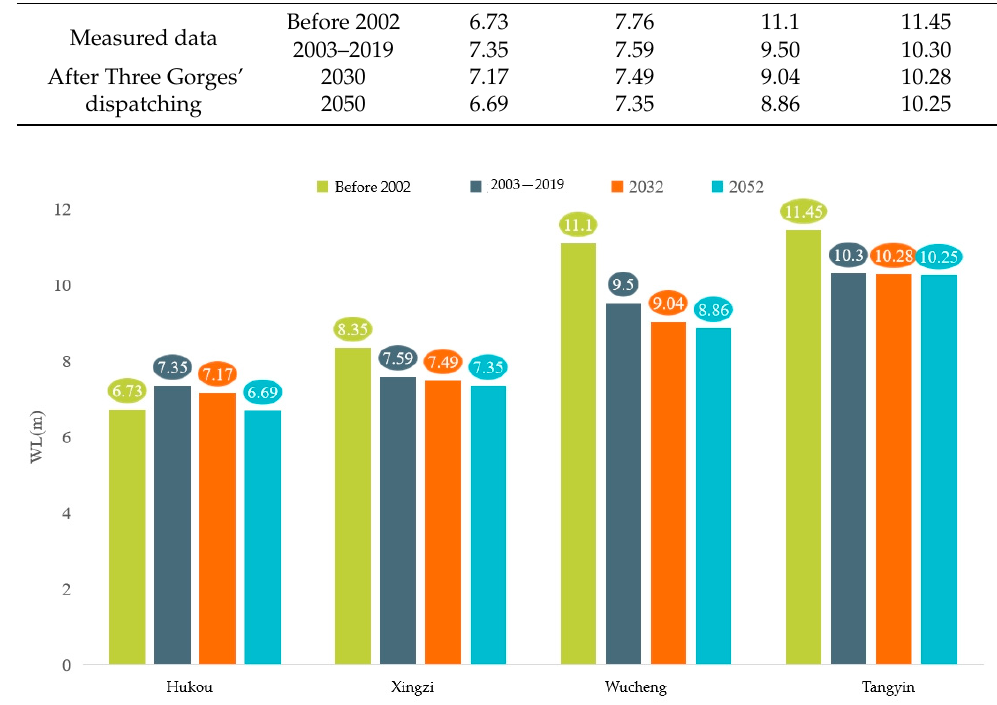
Figure 15. Water level variation at the main hydrometric stations in Poyang Lake.